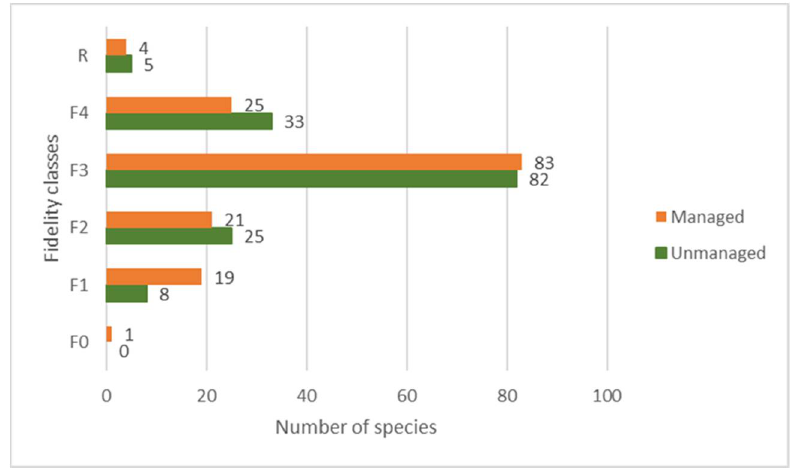
Figure 4. Numbers of species depending on fidelity classes in Coleoptera assemblages in managed and unmanaged pine stands in western Poland.